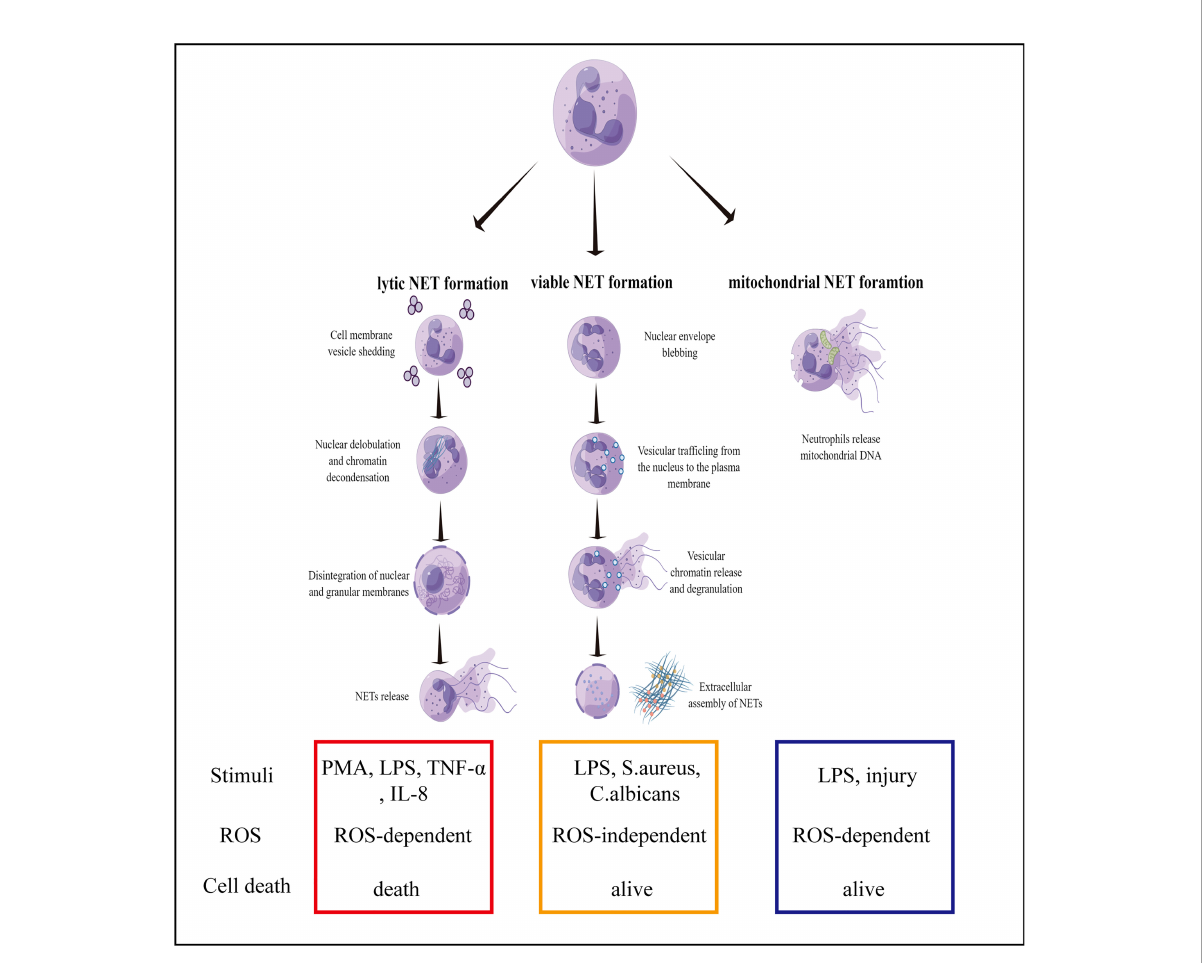
FIGURE 1 Mechanisms of NET formation. Three mechanisms of NET formation have been described: lytic NET formation, viable NET formation, and mitochondrial NET